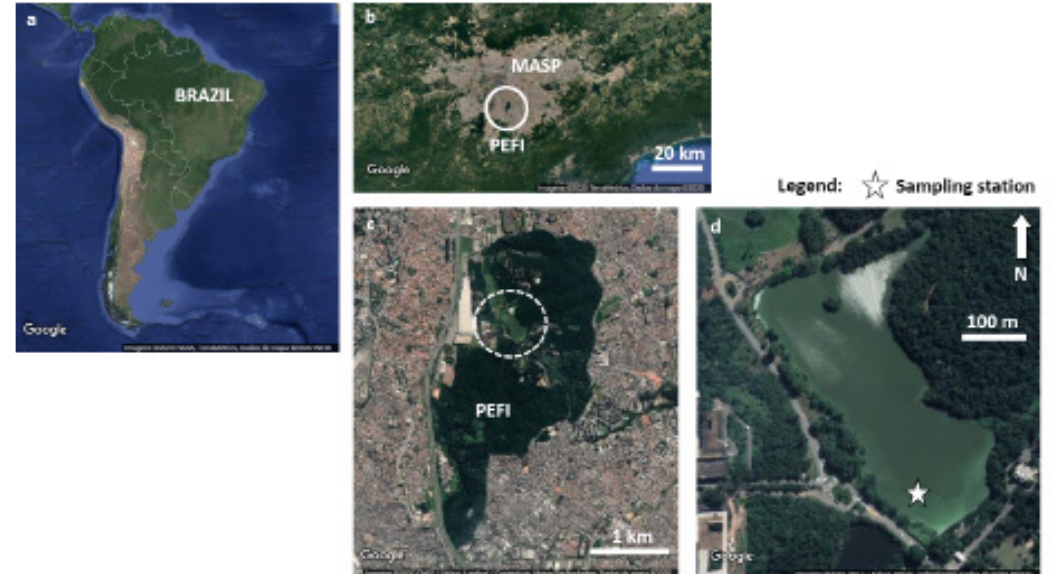
Figure 1. (a) Brazil; (b) Location of Metropolitan Area of São Paulo (MASP) with PEFI area circled; (c) Location of Garças Reservoir in PEFI. (d) Sampling station in Garças Reservoir. Source: Google, NASA, TerraMetrics, INEGI, CNES/ Airbus, Landsat/ Copernicus, Maxar